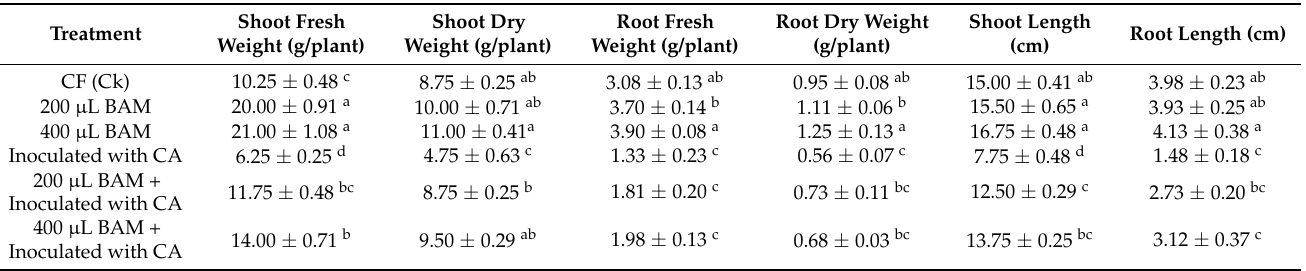
Table 4. Effects of BAM strain on the growth of peanut plants; all the values are the comparison of mean ± SE.